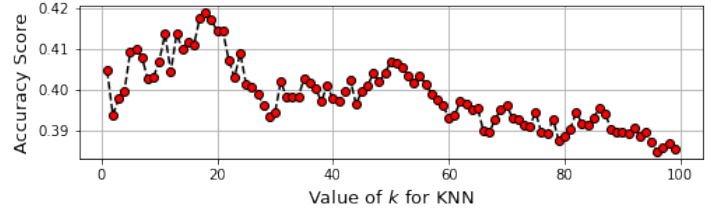
Figure 7. Test accuracy scores produced by the KNN model over different k values.